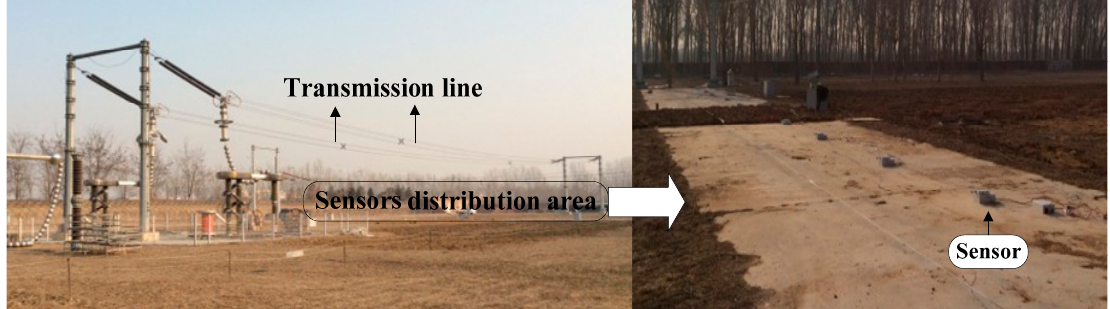
Figure 16. Arrangement diagram of measurement system.